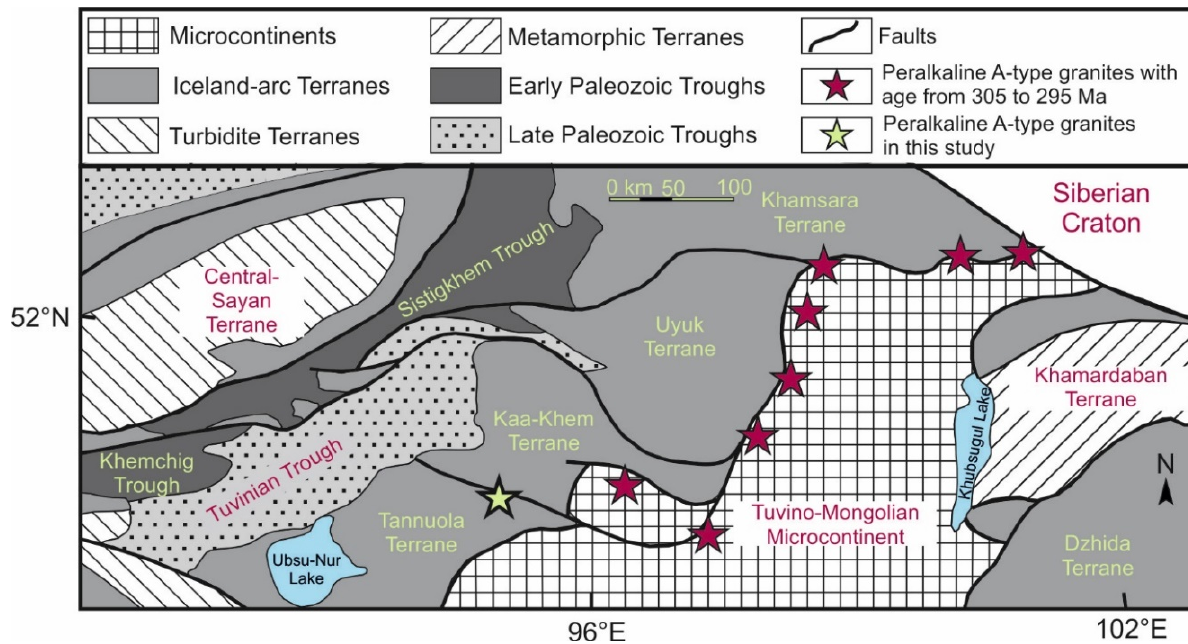
Figure 2. Schematic map showing the position of alkaline magmatism near the Tannuola terrane after [28].